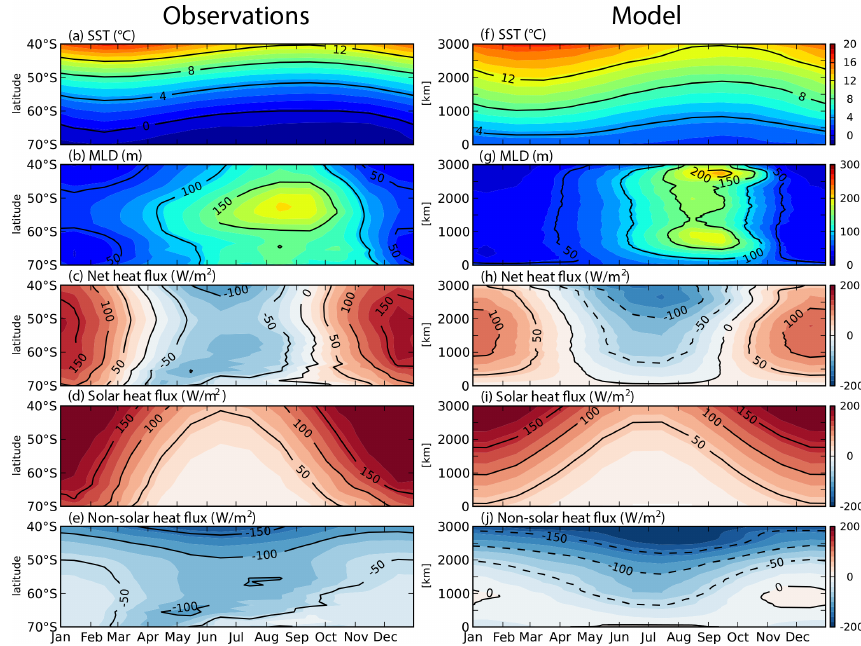
Figure 2. Seasonal cycle of zonally averaged SST ( a, f , ◦ C), mixed-layer depth ( b, g , m) computed in both model and observations with a fixed threshold criterion of 0.2 ◦ C relative to the temperature at 10m, net air–sea heat flux ( c, h , Wm − 2 ) , and the solar ( d, i , Wm − 2 ) and non-solar ( e, j , Wm − 2 ) components of the air–sea heat flux. Climatological seasonal cycles are built from observations (left column) and model outputs and forcing. Observations include OAFlux products (Yu et al., 2007) for the period 1984–2007 and de Boyer Montégut (2004) mixed-layer depth climatology. Model data are from the last 10 years of the 2km reference simulation without